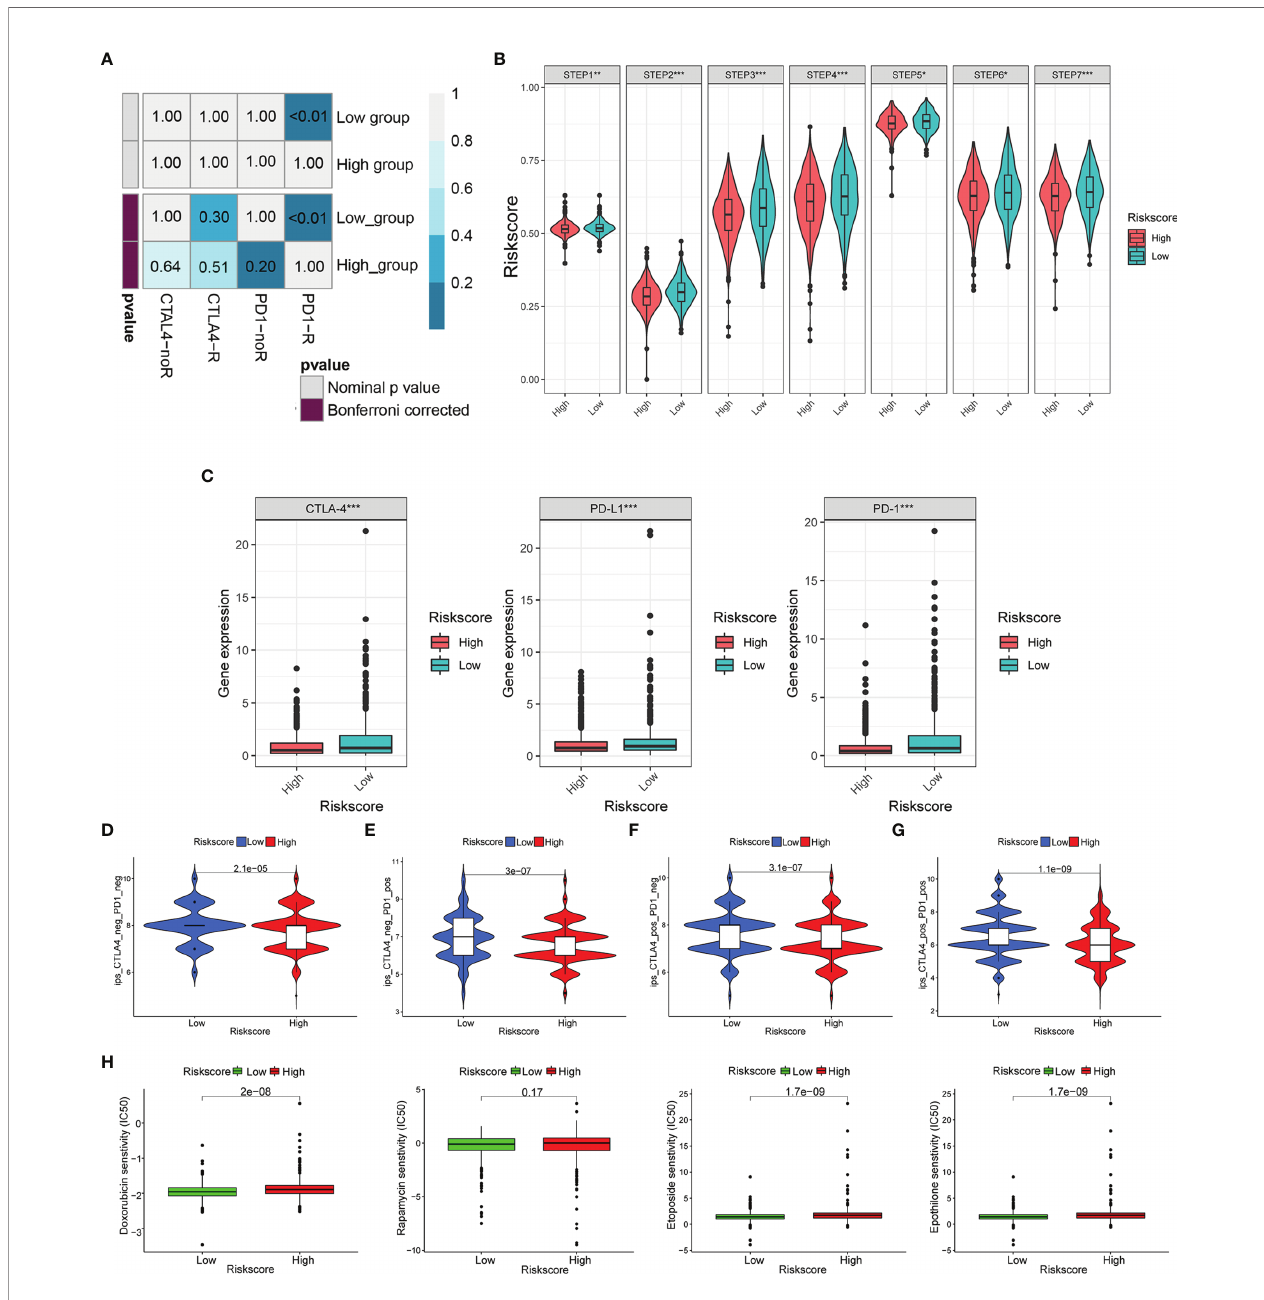
FIGURE 10 | Risk score predicted the responsiveness of BC to chemotherapy and targeted therapy. (A) The possibility of anti-PD1 and anti-CTLA4 response immunotherapy in the 2 groups. (B) The expression of the seven steps of the tumor-immune cycle. (C) The expression of PD1, PD-L1, and CTLA-4. (D – G) Four subtypes of IPS values (ips_CTLA-4_pos_PD-1_pos, ips_CTLA-4_neg_PD-1_pos, ips_CTLA-4_pos_PD-1_neg, and ips_CTLA-4_neg_PD-1_neg). (H) Drug sensitivity of doxorubicin, rapamycin, etoposide, and epothilone in the high-risk and low-risk groups. BC, breast cancer. *p < 0.05, **p < 0.01, ***p <